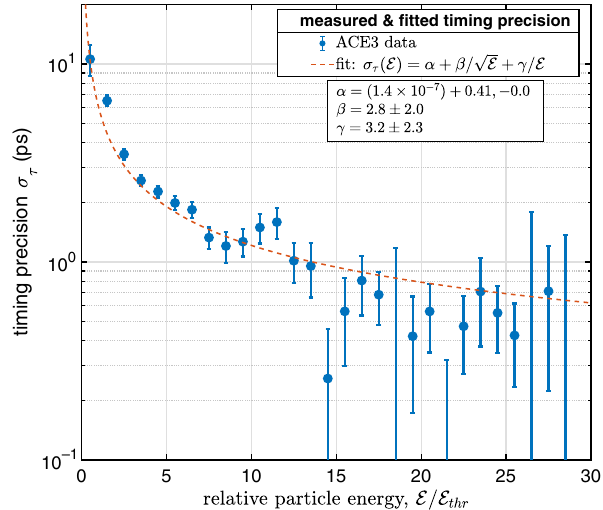
FIG. 16. Single ACE element timing precision vs relative shower energy measured in our